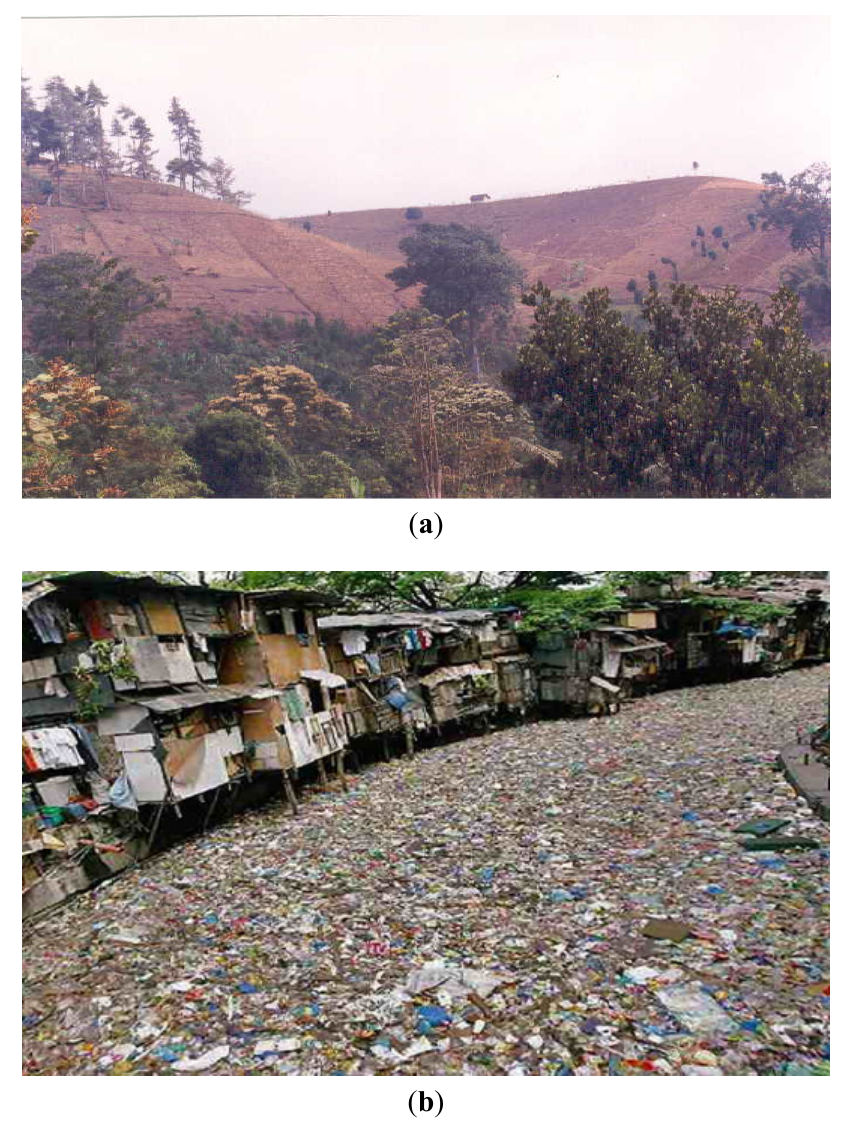
Figure 2. Environmental conditions in the river watersheds; ( a ) critical land area in the upper part of the Brantas River Basin in East Java and ( b ) dirty part of the Citarum River in West